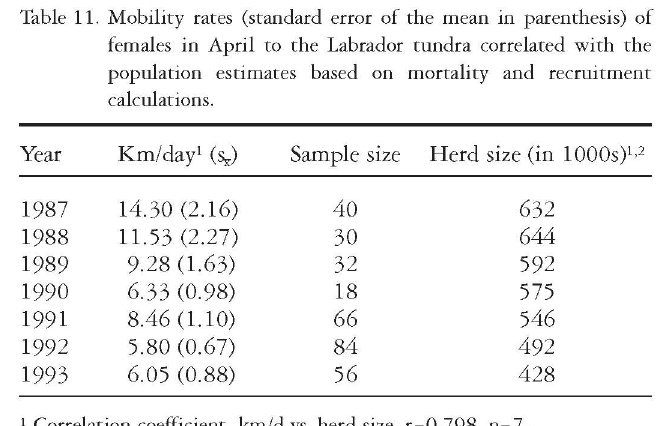
Table 11. Mobility rates (standard error of the mean in parenthesis) of females in April to the Labrador tundra correlated with the population estimates based on mortality and recruitment